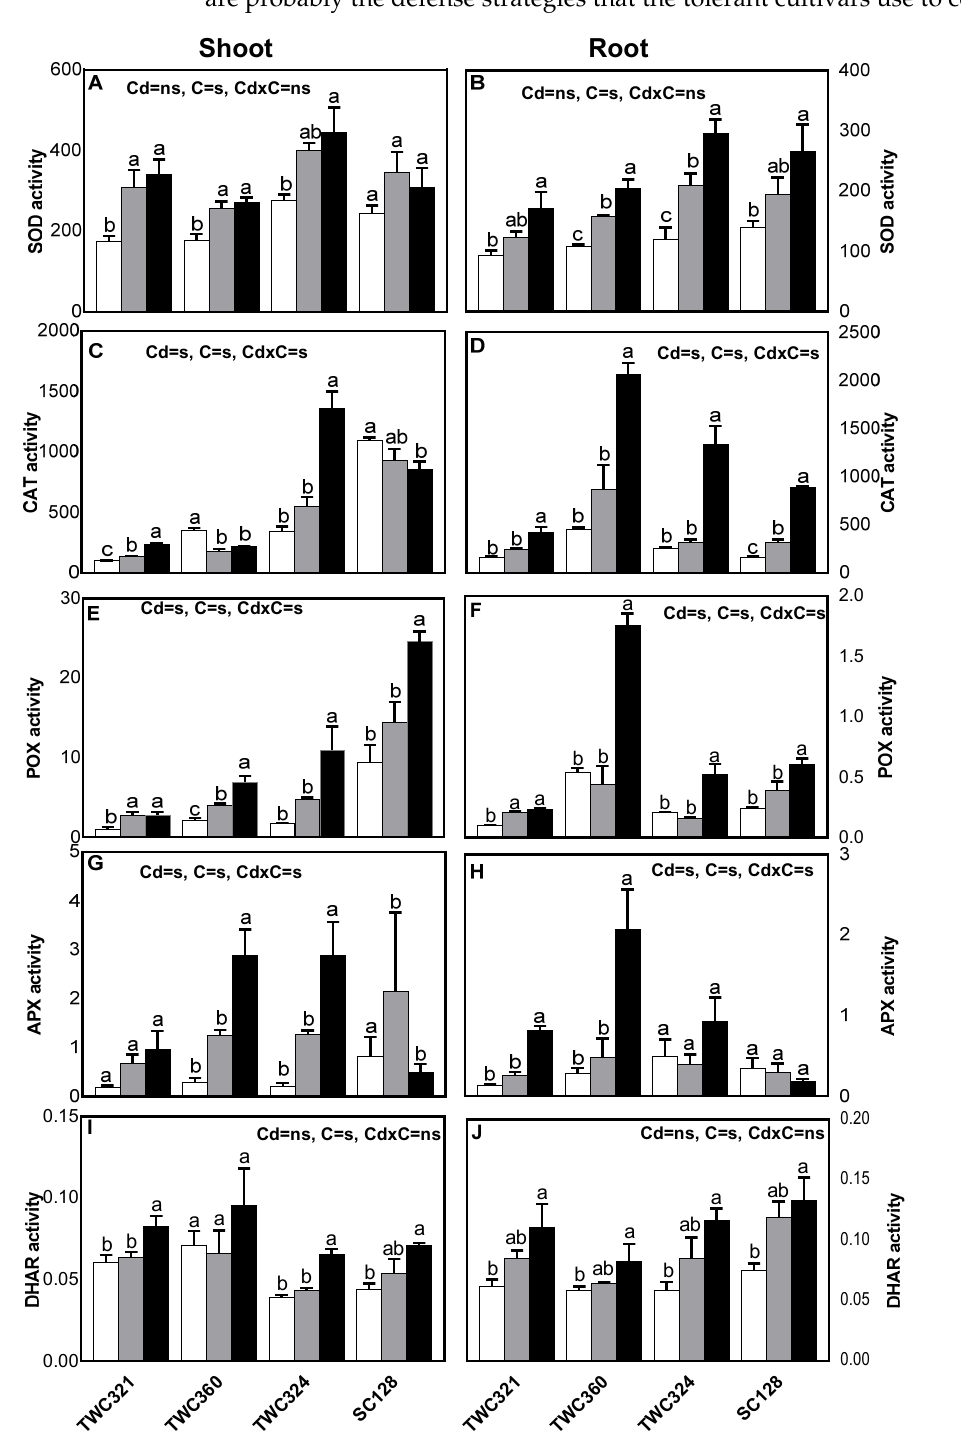
Figure 4. Effect of Cd-stress (C: control, M: mild and S: severe) on activity of ( A , B ) super oxide dismutase (SOD;U SOD mg − 1 protein min − 1 ), ( C , D ) catalase (CAT; µ mol H 2 O 2 mg − 1 protein min − 1 ), ( E , F ) peroxidase (POX; mmol pyrogallol mg − 1 protein min − 1 ), ( G , H ) ascorbate peroxidase (APX; µ mol ASC mg − 1 protein min − 1 ) and ( I , J ) dehydroascorbate reductase (DHAR µ mol ASA mg − 1 protein min − 1 ) of shoot and root of maize cultivars, respectively. Values are expressed as means ± SE ( n = 3). Bars with at least one similar letter within each cultivar indicate non-significant difference ( p ≤ 0.05). Two-way ANOVA was applied to study the effect of the two factors, Cd-stress (Cd) and cultivars (C), as well as their interaction (Cd ×